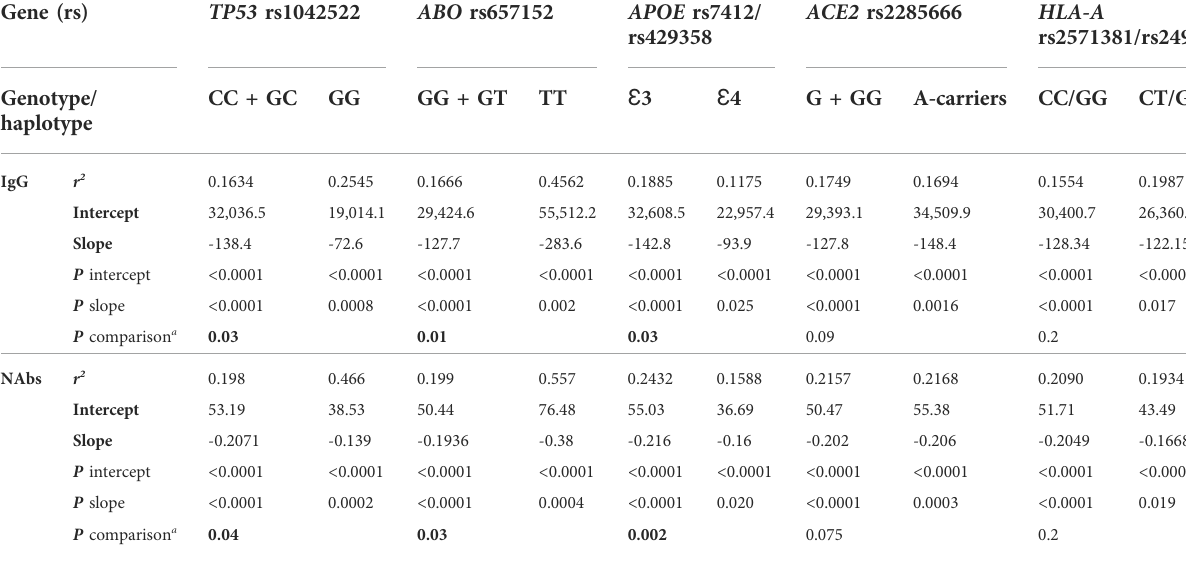
TABLE 3 Regression analysis and genotype comparison of the selected SNPs in the whole